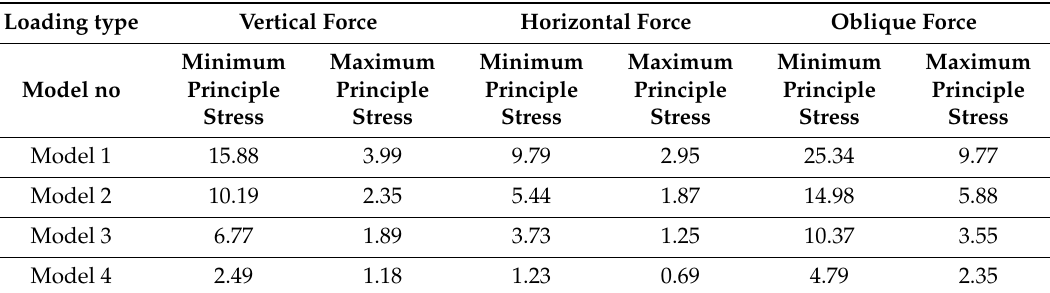
Table 4. Minimum–Maximum Principle Stress in Cancellous Bone (MPa): Max: maximum principle stress; Min: Minimum principle stress.